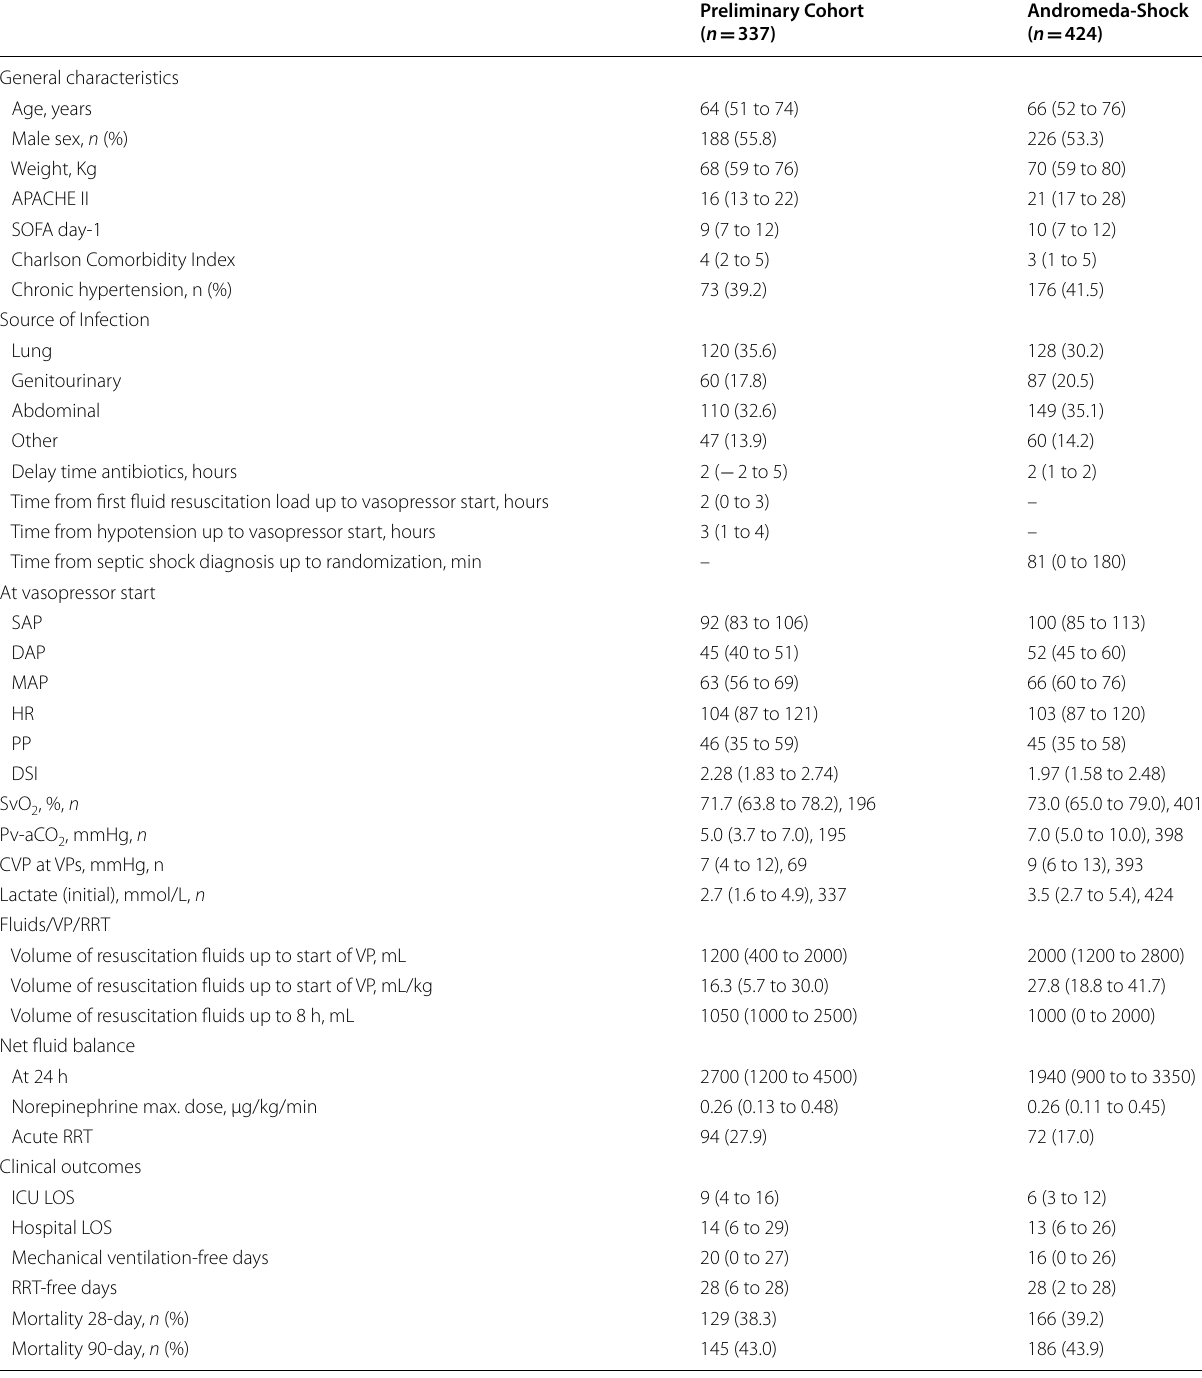
Table 1 General